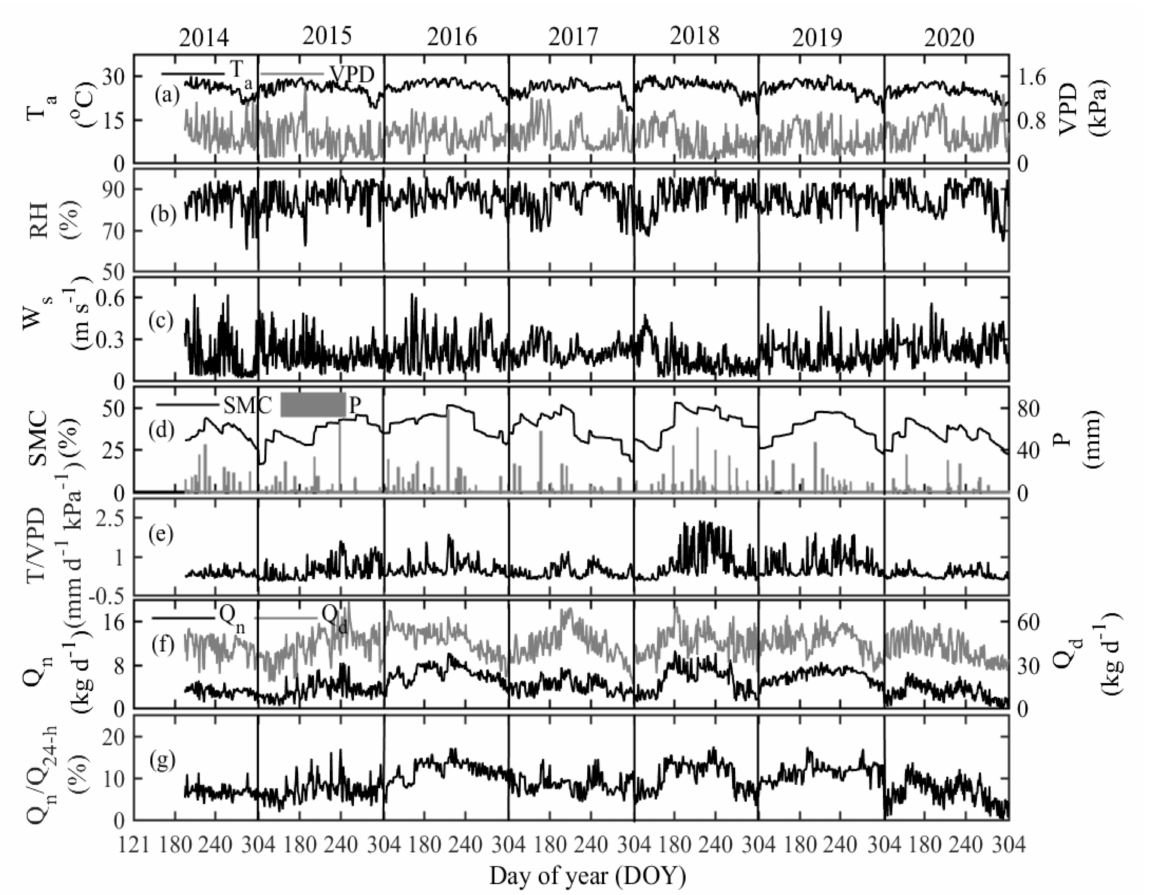
Figure 1. Temporal variations in nighttime mean ( a ) air temperature (T a ), vapor pressure deficit (VPD), ( b ) relative humidity (RH), ( c ) wind speed (W s ), ( d ) soil moisture content (SMC), total nighttime precipitation (P), ( e ) canopy conductance (as indicated by T/VPD), ( f ), nighttime (20:00–05:00), and daytime (06:00–19:00) sap flow rates (Q n and Q d , respectively), and ( g ) fraction of nighttime to total 24-h sap flow (Q n /Q 24-h × 100) during the growing seasons (1 May–31 October) of 2014–2020. The values of SMC are the means of measurements at different depths of 10, 30, 40, and 50 cm over the study site. Note: the data from 1 May to 14 July are missing for